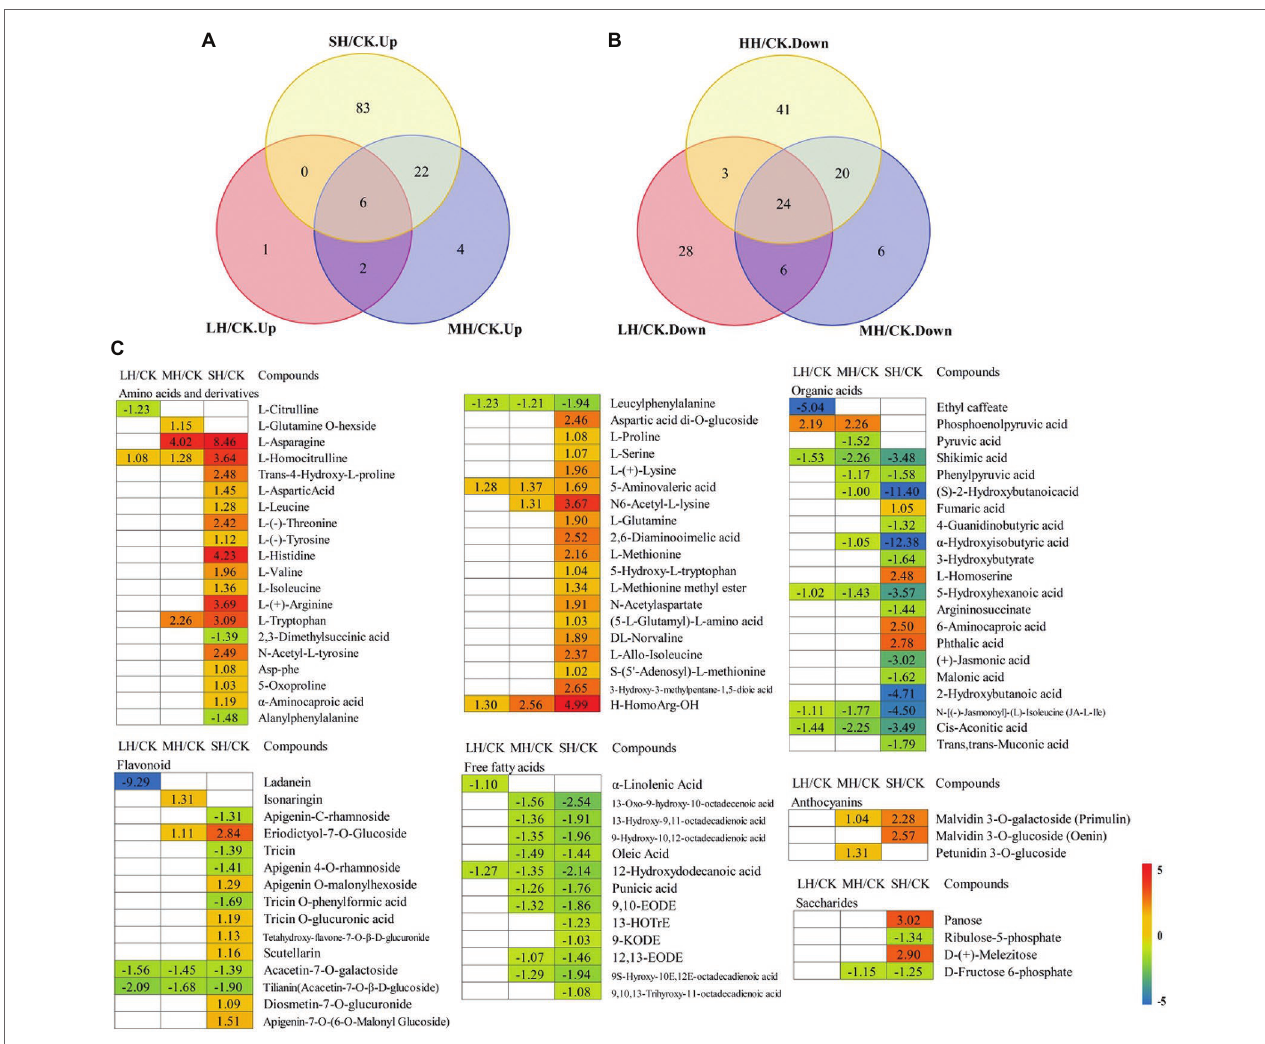
FIGURE 6 | Global view of the distinct and common metabolite target Paspalum wettsteinii in response to high-temperature stress. Venn diagram shows metabolites up- (A) and downregulated (B) by complementary mass spectrometry (GC–MS) analyses in the P. wettsteinii leaves. Differentially accumulated metabolites showed expression changes during temperature treatments” with “Heatmap (C) shows in expression changes of differentially accumulated metabolites under different temperature treatments. The numbers in the rectangles indicate the log 2 (fold-change) of the